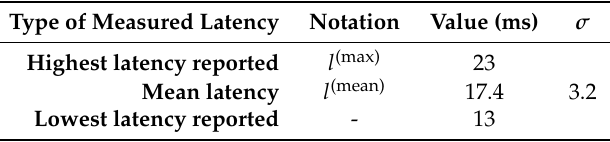
Table 1. Measured send/receive